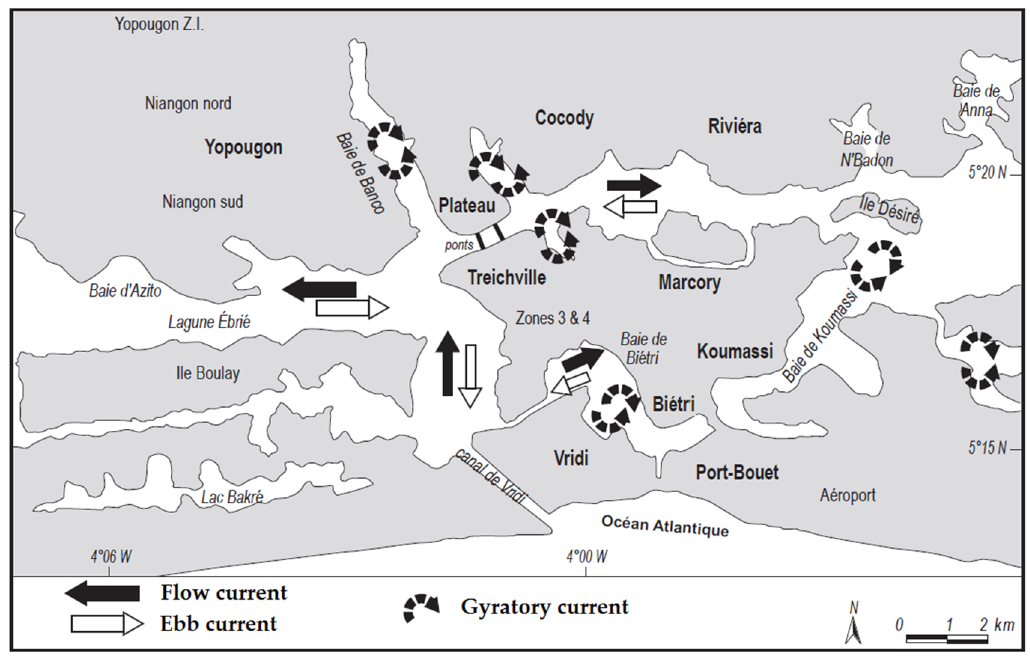
Figure 2. Simplified model of circulation in Ébrié lagoon of Abidjan ( Source: Affian [35]).